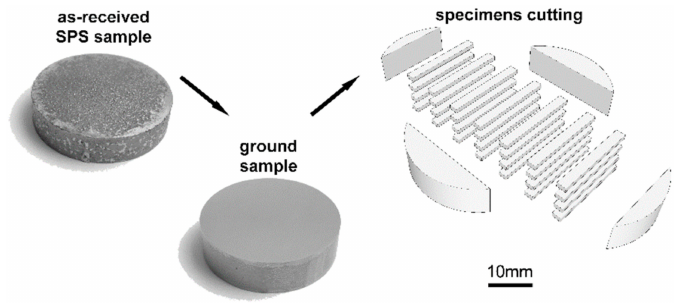
Figure 1. Schematic of the preparation of the specimen from as-sintered spark plasma sintering (SPS) disk. The same three-point bending configuration installed in the Instron Elektropuls 3000 machine as for static tests is employed for the fatigue experiments. The cyclic loading at cycle asymmetry ratio R = 0.1 with the nominal frequency of 20 Hz at ambient temperature was used. The experiments were performed under the load control mode. Fatigue endurance limit based on a minimum of three specimens not broken until reaching 1 × 10 7 cycles was determined for each